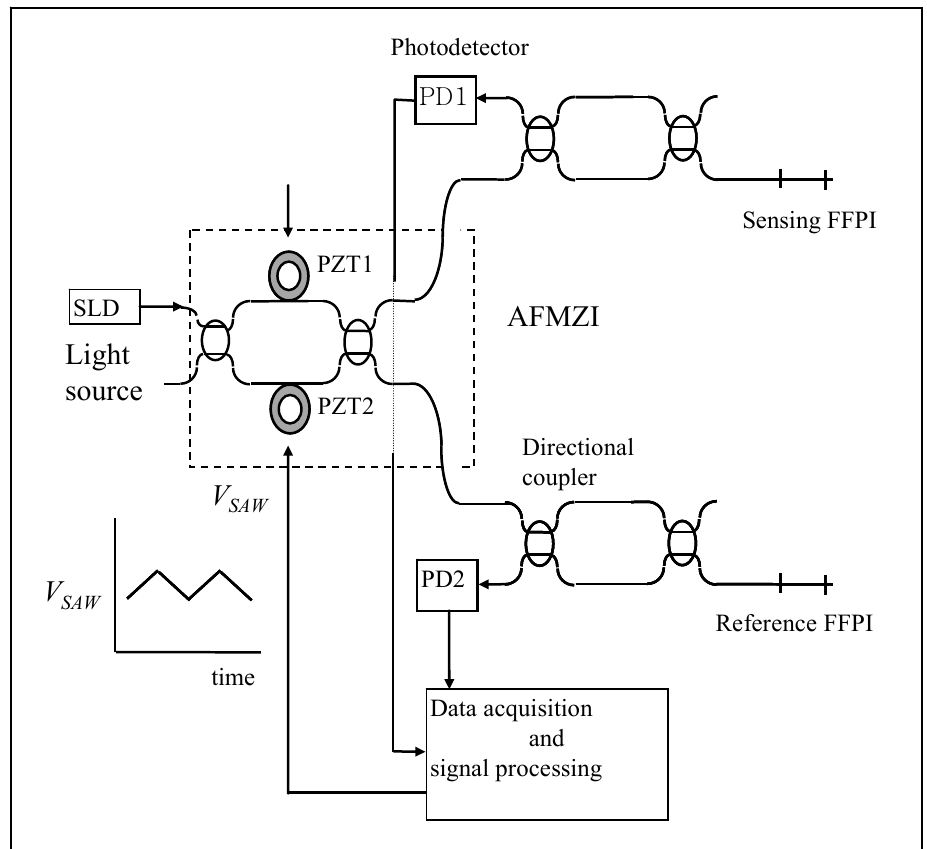
Figure 1 . All Fiber White Light